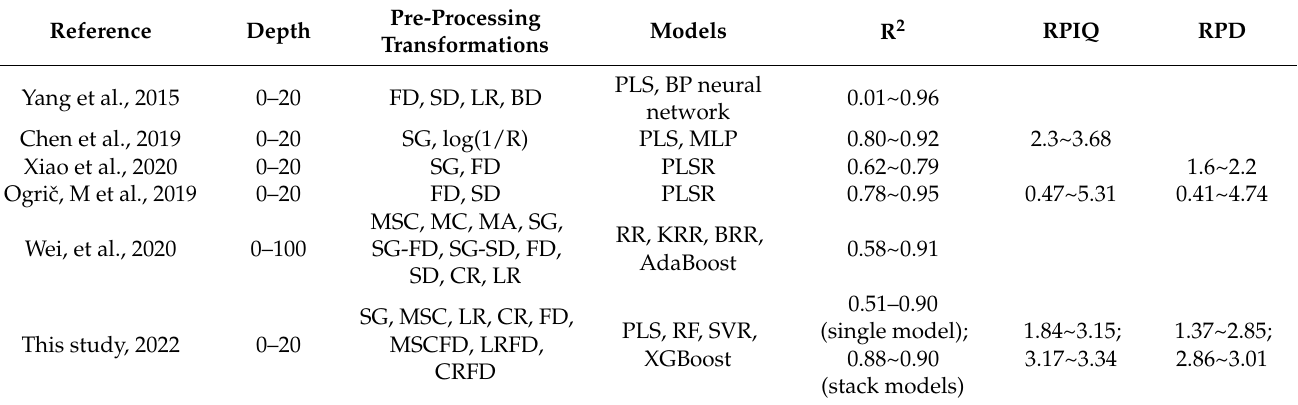
Table 6. Comparison of SOC simulation accuracy in an alpine